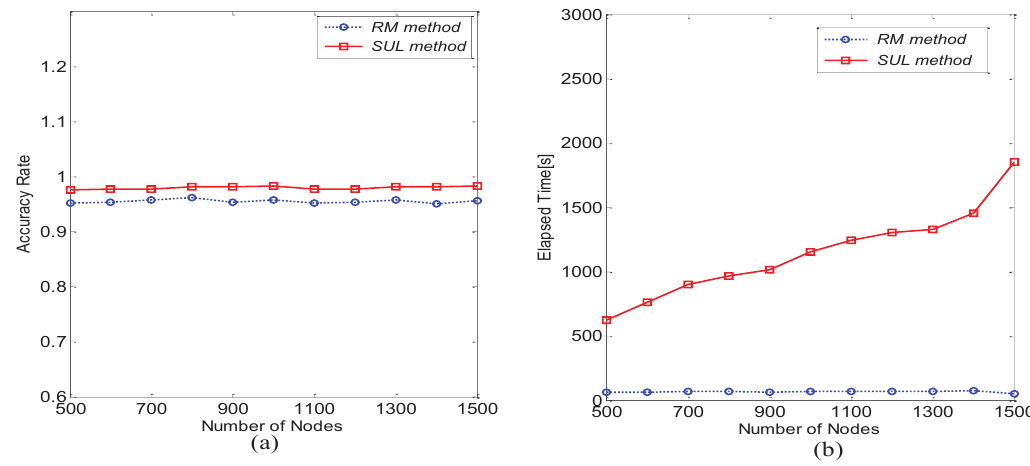
Figure 11. Comparison between the RM method and the SUL method. ( a ) For key nodes’ accuracy rate; ( b ) For elapsed